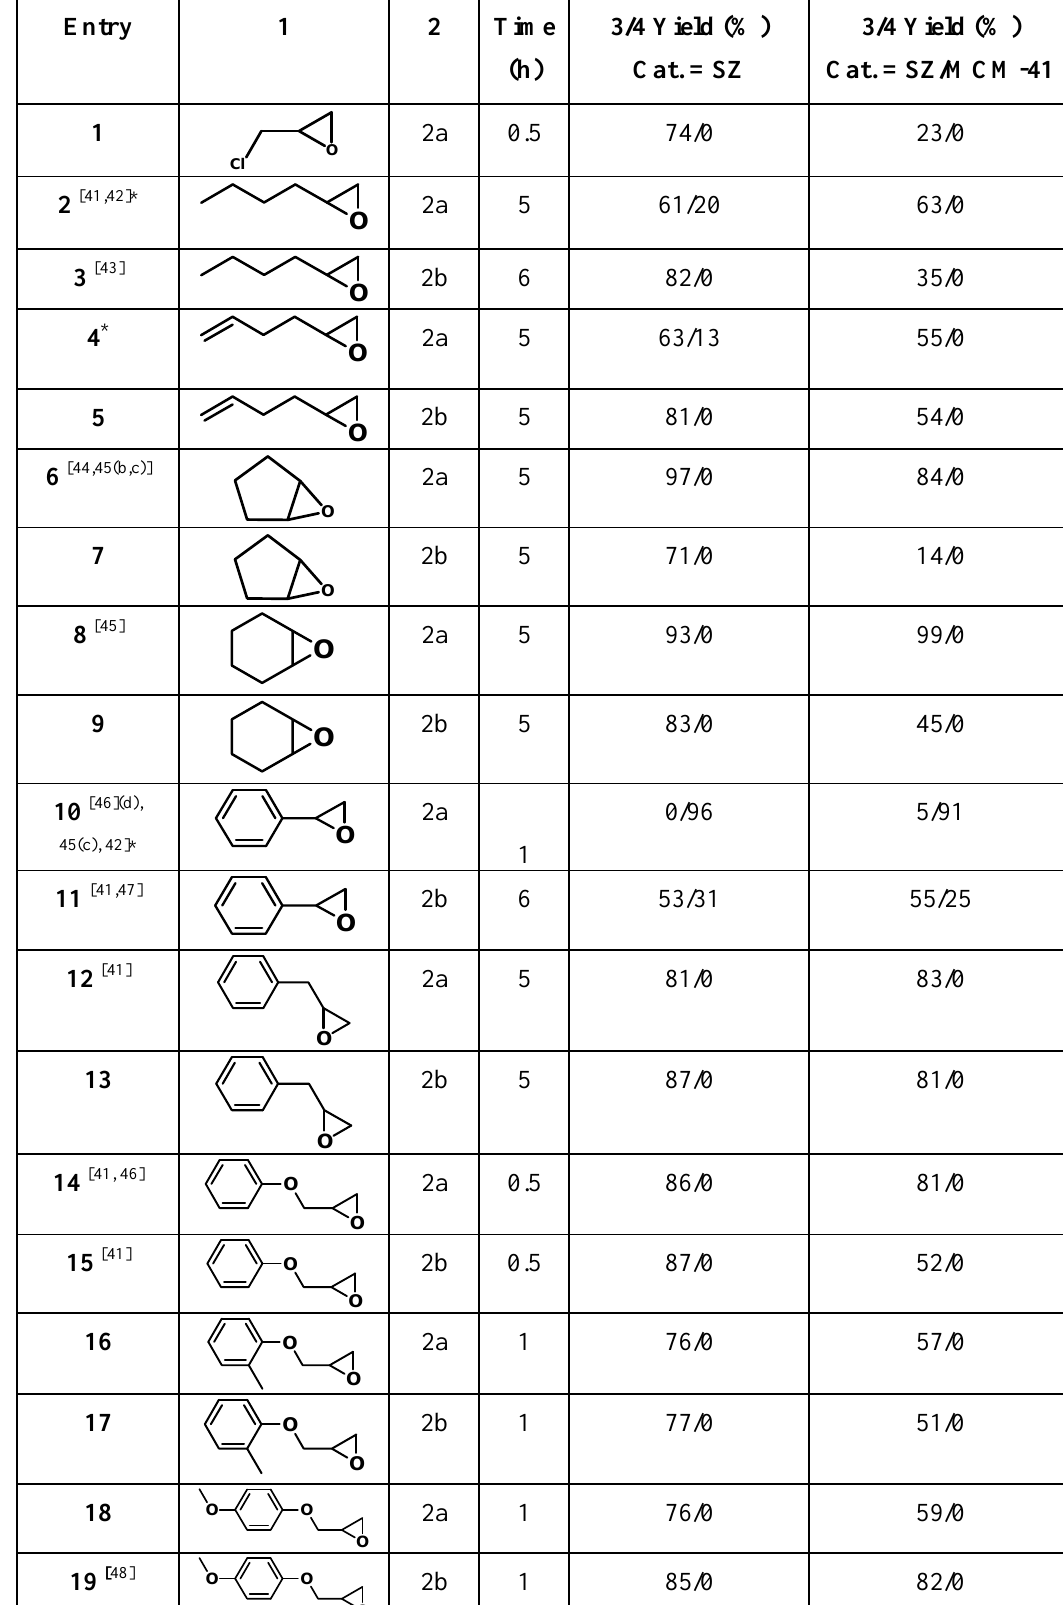
Table 2. SZ and SZ/MCM-41 as